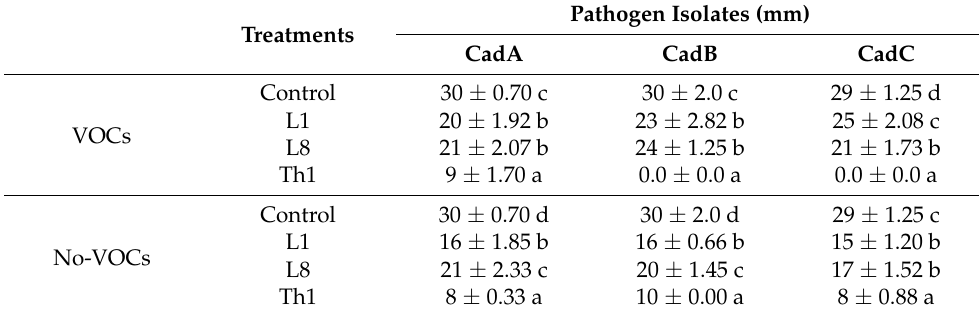
Figure 1. Percentage of inhibition of Cadophora luteo-olivacea isolates (CadA, CadB, CadC) mycelial growth co-cultured with Aureobasidium pullulans (L1 and L8 strains) and Trichoderma harzianum (Th1) for 15 days at 20 °C. Data were analyzed using one-way ANOVA. Within C. luteo-olivacea isolate, different letters represent significant differences among BCAs to evaluate their efficacy according to Tukey’s HSD Test ( α = 0.05). Table 1. Effect of different treatments (VOCs and No-VOCs by L1, L8, and Th1) on the development of Cadophora luteo-olivacea isolates (CadA, CadB, CadC) mycelial growth (mm). Data were analyzed using one-way ANOVA. Within C. luteo-olivacea isolate and treatment (VOCs and No-VOCs), different letters represent significant differences among BCAs to evaluate their efficacy according to Tukey’s HSD Test ( α =